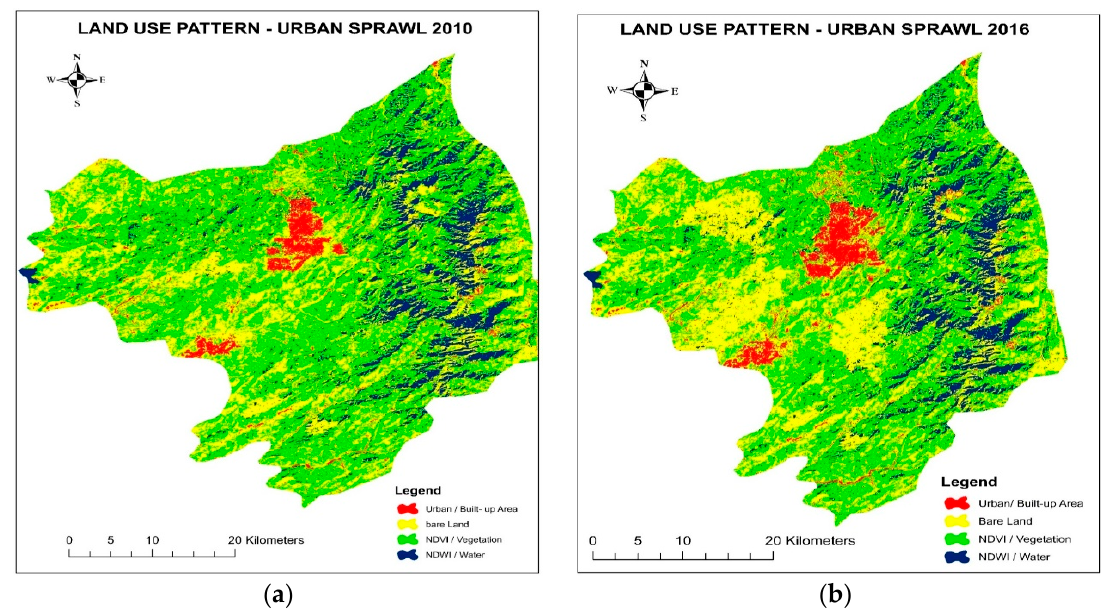
Figure 5. ( a ) Land use pattern—urban sprawl 2010 and ( b ) land use pattern—urban sprawl 2016.